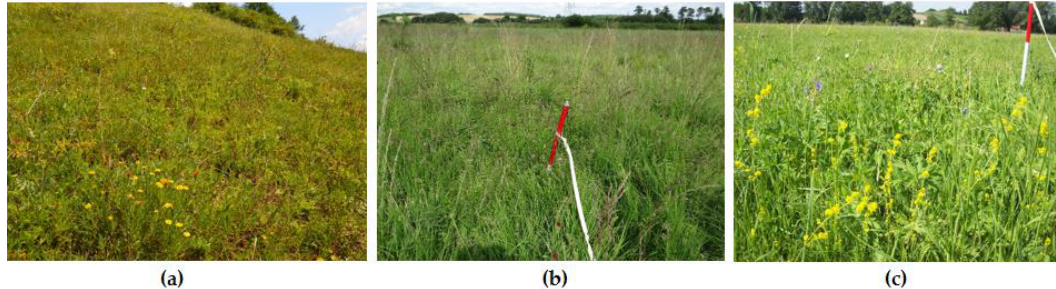
Figure 2. Selected Natura 2000 habitats in Ostoja Nidziańska area: ( a ) 6210; ( b ) 6410; ( c ) 6510 (photos by: B. Tokarska-Guzik, B. Babczyńska-Sendek and T. Nowak, all taken in July).